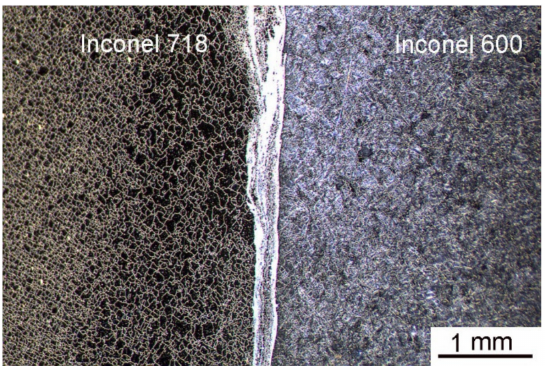
Figure 2. Macrograph of Inconel 718/Inconel 600 dissimilar friction weld.